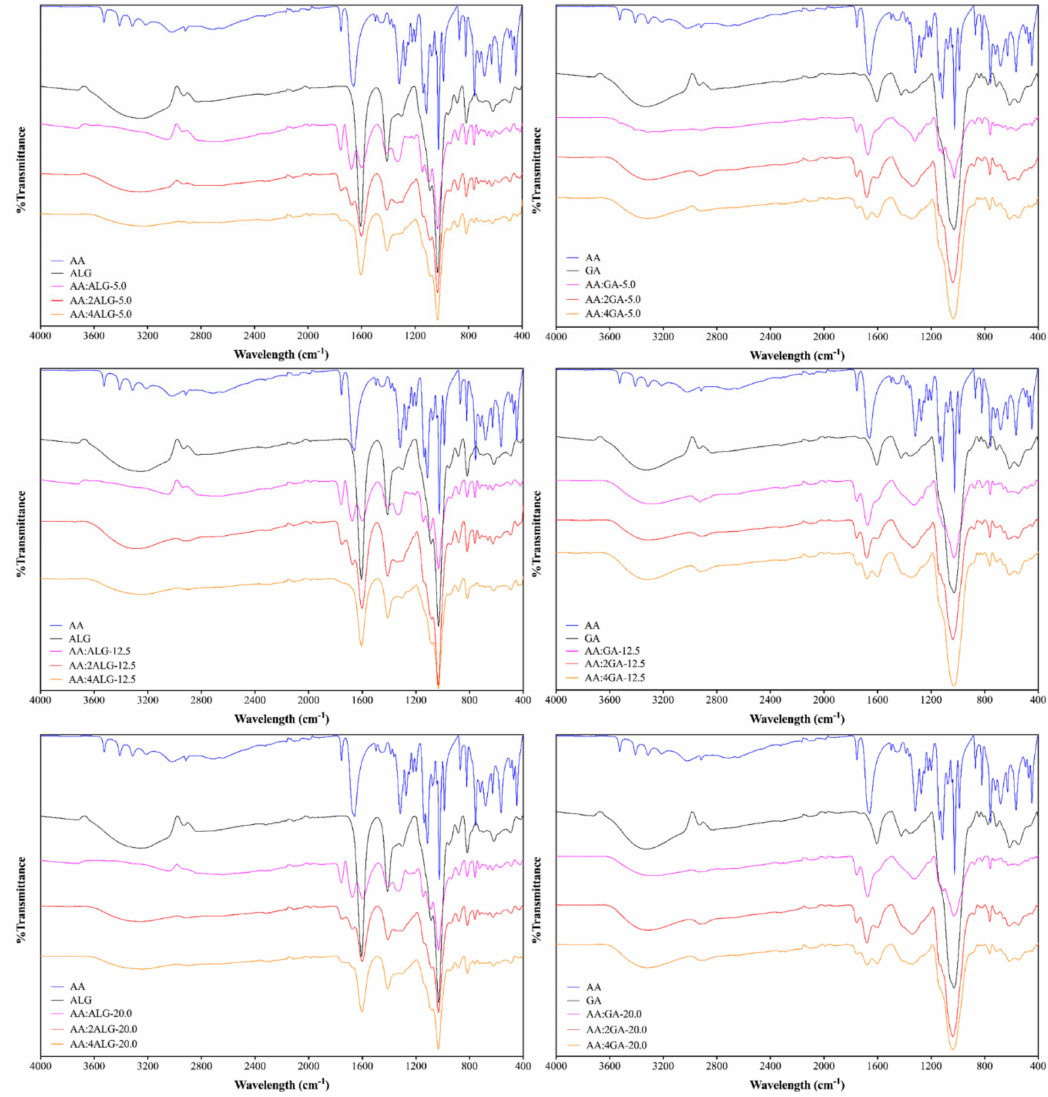
Figure 4. FTIR spectra of AA microparticles using ALG (left) and GA (right) as wall